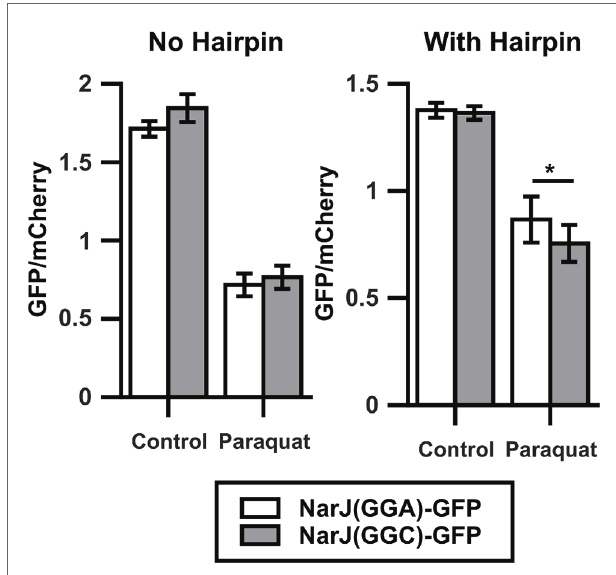
FIGURE 3 | Oxidative stress alters translation of Gly codons in natural context. Left graph shows the GFP/mCherry fluorescence ratio for narJ [NarJ(GGA)-GFP, white] or a mutant of the gene where a contiguous GGA pair was changed for a pair of GGC [NarJ(GGC)-GFP, gray] cloned in fusion to GFP. Shown in the right graph are similar experiments performed after introducing a hairpin that prevents ribosome sliding between the sequences coding for GFP and mCherry. * p < 0.05, two-tailed t -test ( n =